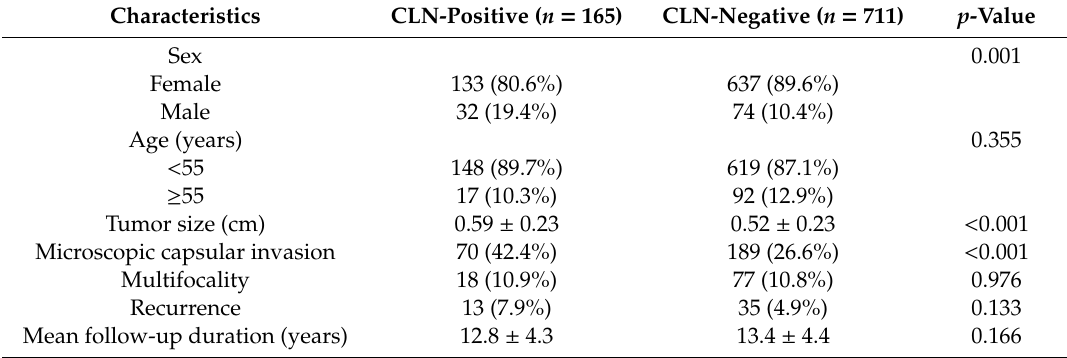
Table 1. Clinicopathologiccharacteristicsofthecentrallymphnode(CLN)-positiveandCLN-negativegroups.